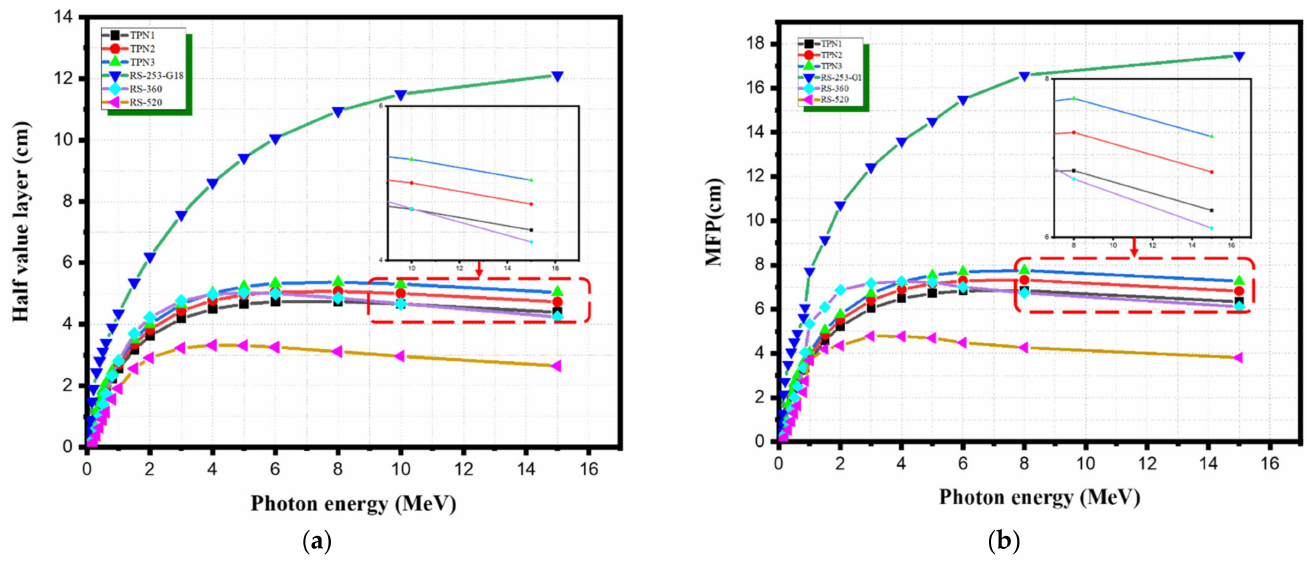
Figure 6. The shielding parameters for TPN and standard materials: ( a ) HVL; ( b ) MFP. The calculated values of the effective atomic number (Z eff ) and the effective electron number (N eff ) of TPN glass systems are shown in Figure 7a,b and Table 5. These values show that Z eff and N eff both had a significant dependence on photon energy and the glass material composition. The recorded values of Z eff were in the range of 17 to 50, while those of N eff ranged from 2.7 to 8.11 × 10 23 electrons per gram. The discontinuity that appeared